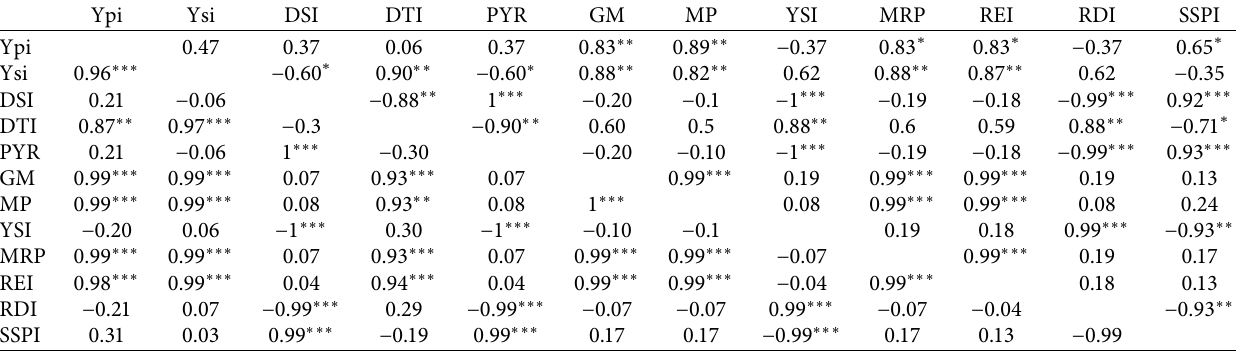
Table 5: Simple correlation analysis among drought tolerance indices for drought stress at the vegetative stage below diagonal and drought stress at the flowering stage above diagonal.